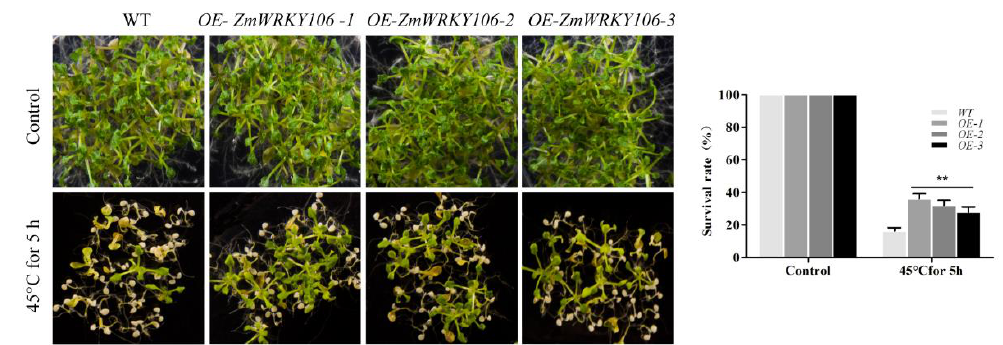
Figure 6. Survival rates of WT and ZmWRKY106 transgenic lines under heat stress. Five-day-old seedlings were placed at 45 °C for 5 h and then resumed growth at 22 °C. The data represent the means ± SDs of three independent biological replicates. Asterisks (**) represent the significant differences ( p < 0.01) compared with the control (Student’s t -test).